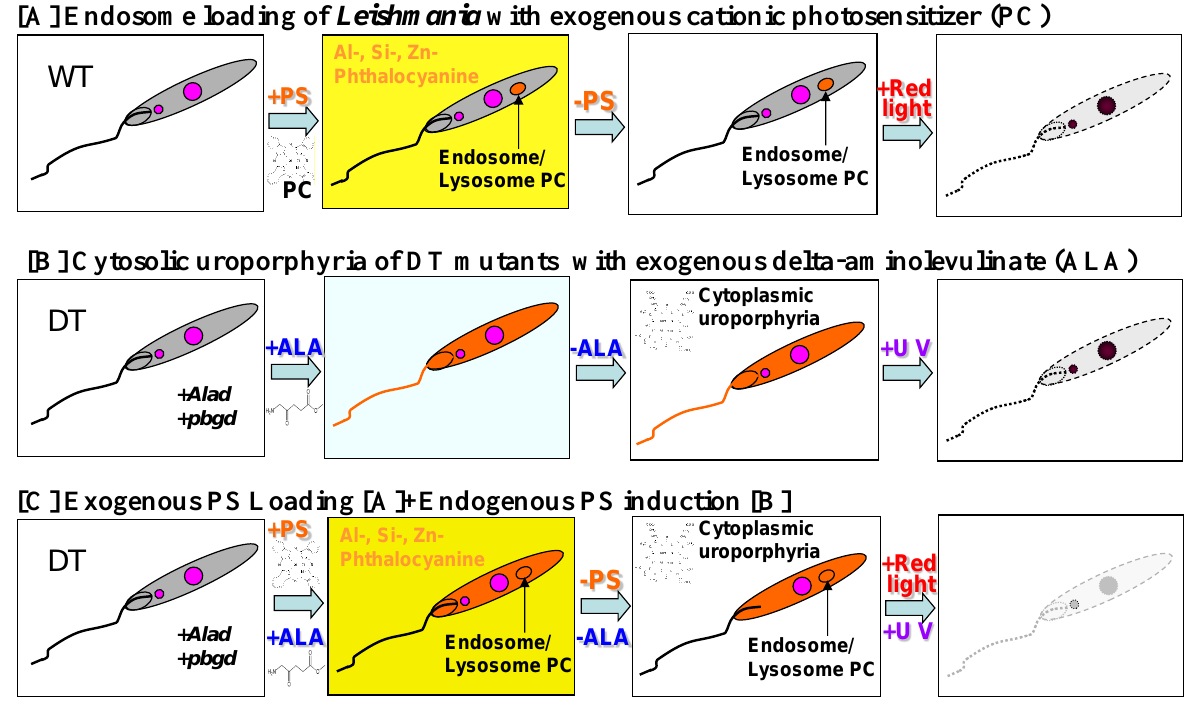
Figure 1. Schematic depiction of endosomal and cytosolic loading of Leishmania with different pho- tosensitizers for complete inactivation by light exposure. ( A ) Photosensitizers (PS) used include phthalocyanines (PC) with different coordinating metals (Al, Si, Zn), which are engi- neered during chemical synthesis to have different axial ligands, such as amino groups for cationicity. Wildtype (WT) Leishmania take up these cationic PCs (+PS) in vitro by en- docytosis into their endosome/lysosome vacuoles, rendering them sensitive to red light inactivation (see Section 3.6.2). ( B ) Leishmania doubly transfected with mammalian cDNAs (DT) to express the 2nd and 3rd enzymes (+Alad,+pbgd) in the heme biosynthetic pathway undergo uroporphyrinogenesis, i.e., production and accumulation of xenogenic uropor- phyrin 1 in the cytosol when exposed to the products of the 1st enzyme in this pathway, i.e., delta-aminolevulinate (+ALA) (see Section 3.6.2). Exposure of the uroporphyric Leish- mania to longwave UV results in their rapid inactivation. ( C ) Double loading of Leishmania with a combination of cationic amino-phthalocyanine exogenously [A] and uroporphyrin 1 endogenously [B] ensures their photosensitization for complete inactivation on light ex- posure. Live Leishmania can be an effective vaccine platform, as shown by their use for Leish- manization (see Section 3.6.1). As such, its clinical applications have limits. For example, leishmanization results in the formation of skin lesions, which may on rare occasions be- come protracted, requiring weeks to heal even in healthy individuals with apparently in- tact immune systems. Leishmanization is off-limits to those who are immunologically de- ficient congenitally or due to immunosuppressive infections, e.g., HIV or under immuno- suppression after organ transplantation. A new approach was devised to render Leishmania totally non-viable and thus non- disease-causing with minimal loss of their adjuvanticity. Their use as a vaccine platform is thus not only effective but also made safe. A dual light-activatable suicidal mechanism was installed in Leishmania to achieve this (Figure 1A – C). We first exploited its natural